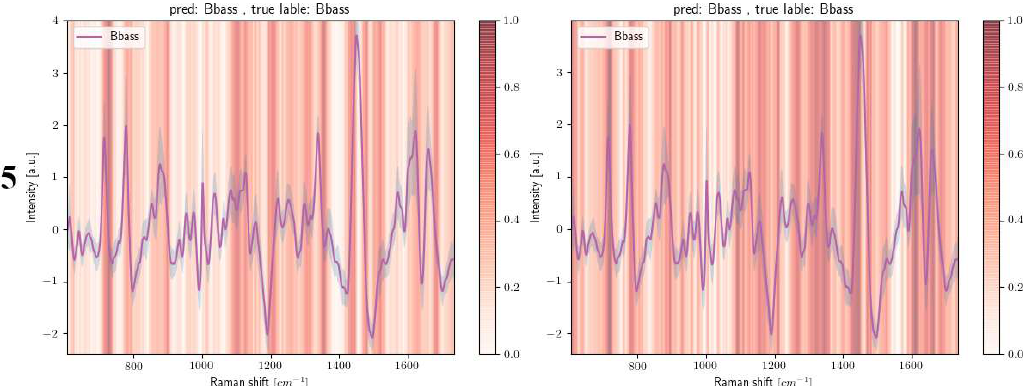
Figure 4. Mean Raman spectra of fungal spores Cb16III ( A1 ), Ca8II ( A2 ), Cb15 ( A3 ), Mpemp ( A4 ), Bbass ( A5 ) and normalized Grad-CAM indicator of CNN used signatures of model 1. Mean Raman spectra of fungal spores Cb16III ( B1 ), Ca8II ( B2 ), Cb15 ( B3 ), Mpemp ( B4 ), Bbass ( B5 ) and normalized Grad-CAM indicator of CNN used signatures of model 2. Z-score normalized Raman intensities on the Y -axis and Grad-CAM indicator normalized from zero to one (white to dark red).